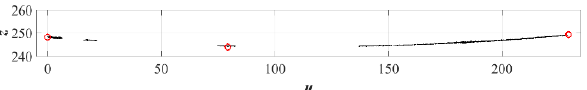
Figure 3. Location of points in the cloud segment to find initial catenary